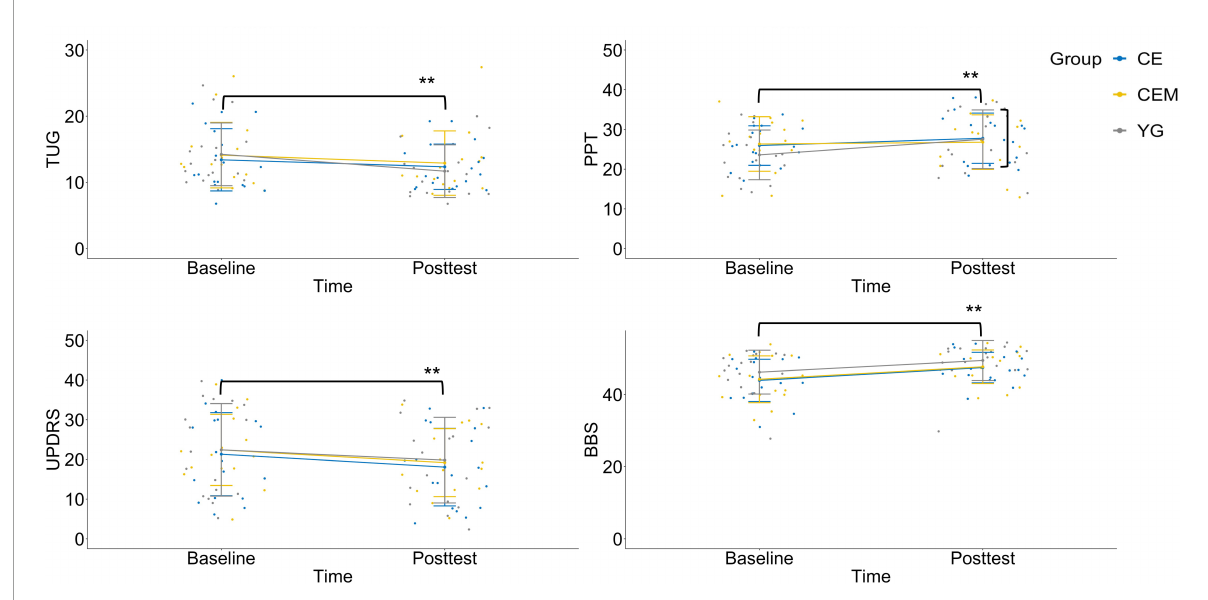
FIGURE2 Interaction charts for behavioral outcomes. TUG, timed-up-and-go test; PPT, Purdue pegboard test; UPDRS, Unified Parkinson’s Disease Rating Scale-motor examination; BBS, Berg balance scale; CE, conventional exercise; CEM, conventional exercise plus music; YG, Yang-ge dancing. ** p <